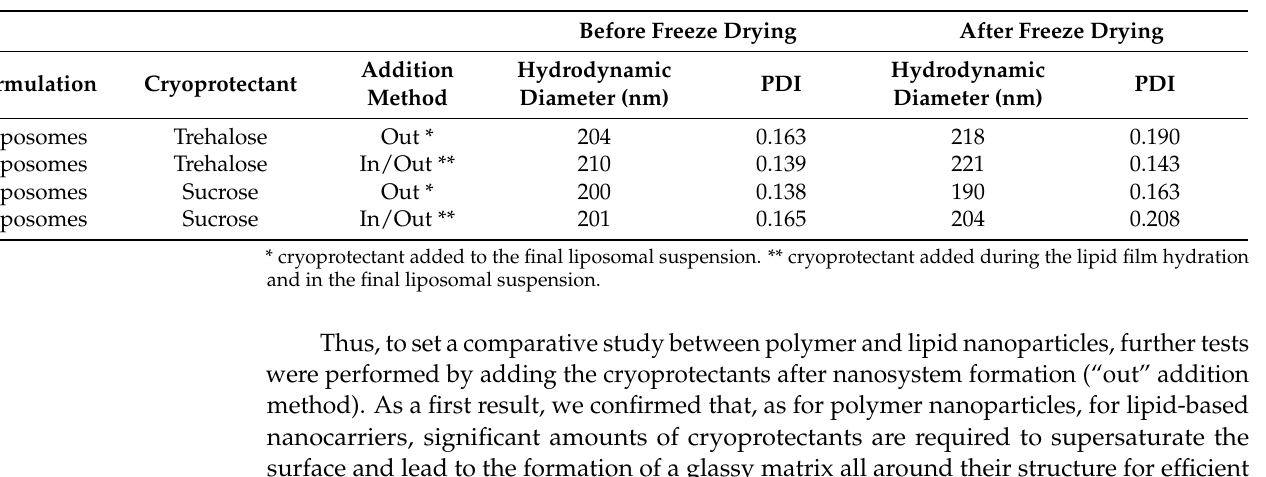
Table 2. Mean hydrodynamic diameter and PDI of liposomes before and after freeze-drying using a disaccharide:lipid ratio of 5:1 ( w / w ) ( n = 3).